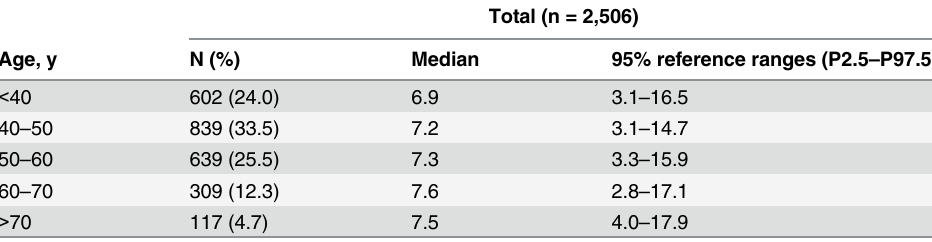
Table 2. Reference ranges for serum erythropoietin (IU/L) levels per age group for subjects in the ref- erence sample.